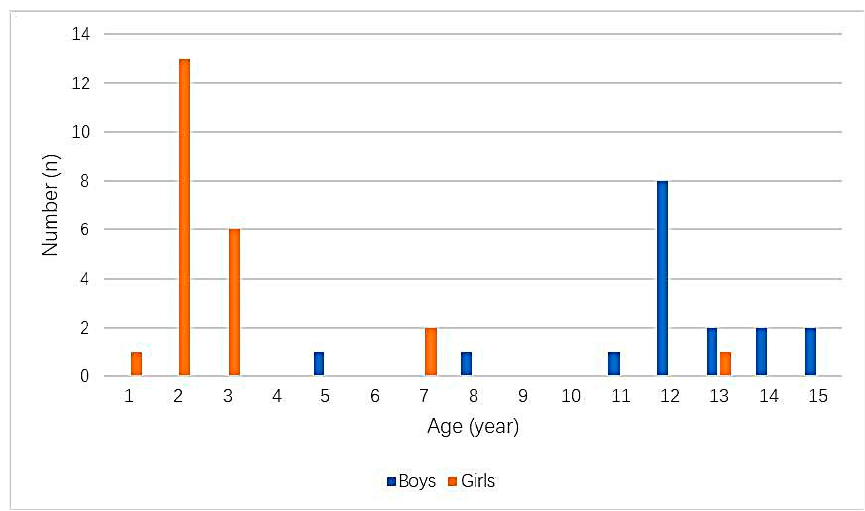
Figure 3. Type and quantity of urethral foreign bodies in boys and girls.